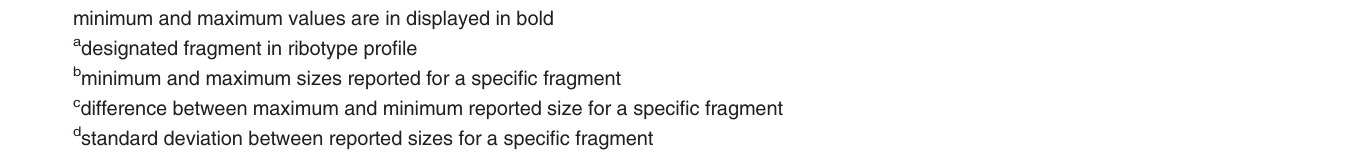
minimum and maximum values are in displayed in bold a designated fragment in ribotype pro fi le b minimum and maximum sizes reported for a speci fi c fragment c difference between maximum and minimum reported size for a speci fi c fragment d standard deviation between reported sizes for a speci fi c fragment